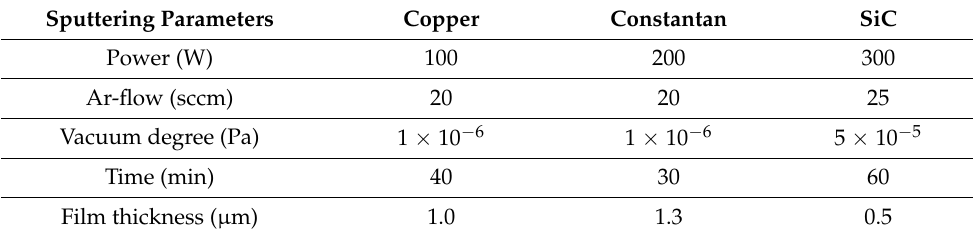
Figure 3. The fabrication process of the sensor and the sample. Table 2. The sputtering parameters of three-dimensional probe array temperature